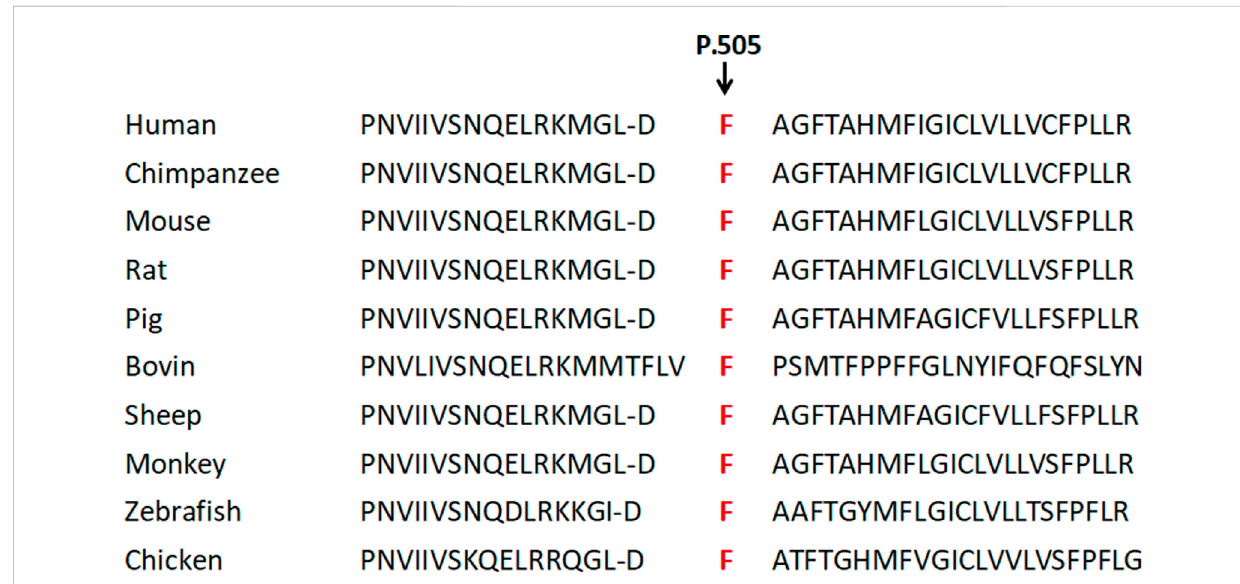
FIGURE 8 Physical sketch map of the p gene, STRs, and primers (1 – 7, A – D, D1 – D7) as well as the breakpoints on the chromosome region 15q11.2-q13. (BP1, breakpoint 1; BP2, breakpoint 2; BP3, breakpoint